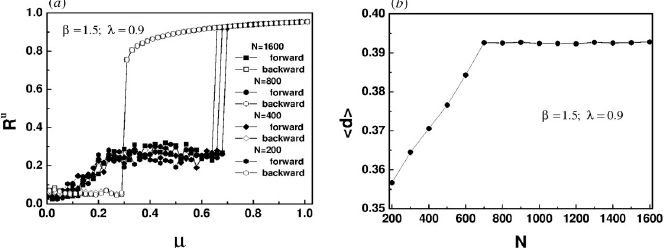
Fig 9. (a) Synchronization and desynchronization diagrams of upper layers with different sizes. (b) Dependence of hysteresis loop width on network size. Other parameters are set to β = 1.5 and λ =